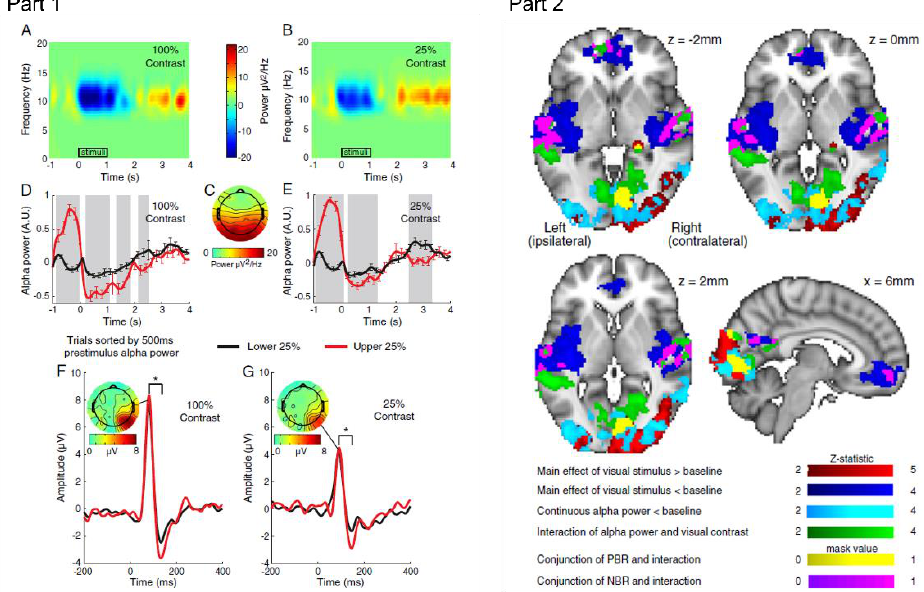
Figure 7. Part 1. Group average time–frequency spectrograms of HC ( A ) and LC ( B ) stimulus induced alpha response with group average bilateral scalp topography of occipital alpha-power ( C ). Black rectangles denote duration of stimulation. Effect of pre-stimulus alpha-power on the HC ( D ) and LC ( E ) alpha-power time course and HC ( F ) and LC ( G ) VEPs. Black and red lines denote lower and upper quartiles of pre-stimulus alpha-power, respectively. Grey shading denotes significant difference ( p < 0.05) in amplitude between quartiles. Error bars represent standard error in the mean. * denotes significant ( p < 0.05) difference in VEP P100–N140 amplitude between quartiles. Part 2. Mixed effects group Z-statistic maps (all cluster corrected Z > 2.0, p < 0.05) of EEG–fMRI GLM results. Positive (red) and negative (dark blue) BOLD responses to constant amplitude main effect of visual stimulation overlaid with a negative correlation between the BOLD signal and continuous alpha power (light blue). A significant negative interaction between continuous alpha-power and the main effect of the visual stimulus contrast was observed (green) in visual and auditory cortices, precuneus and mPFC. The conjunction of the interaction with visual cortex positive BOLD regions is shown in yellow, and with auditory and DMN negative BOLD regions in purple. Reproduced